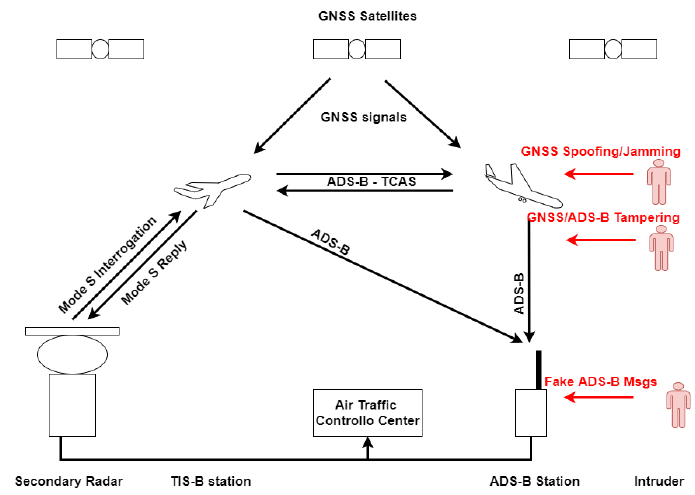
Figure 1. ADS-B system architecture. Possible attacks are in